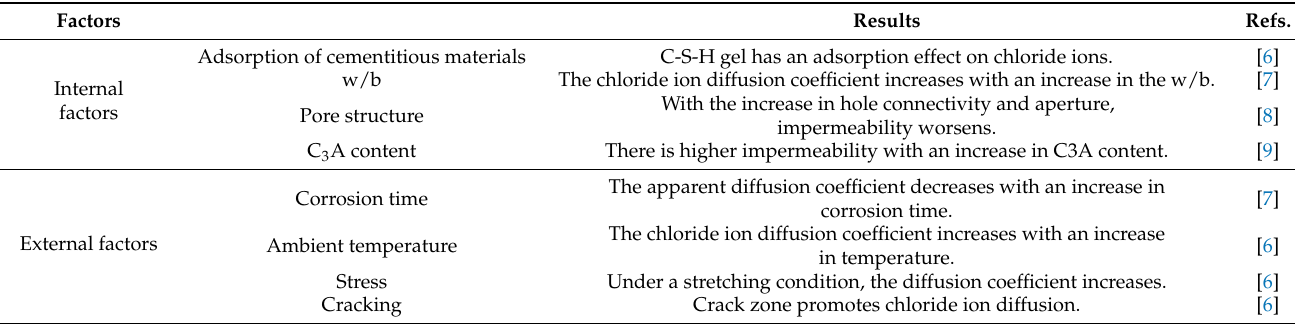
Table 1. Factors affecting the chloride penetration of OPC